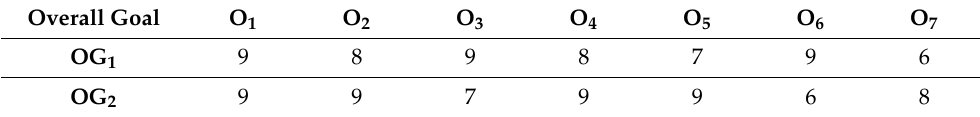
Table A2. Expert’s preference rating of the clinic’s operational objectives with respect to goals.